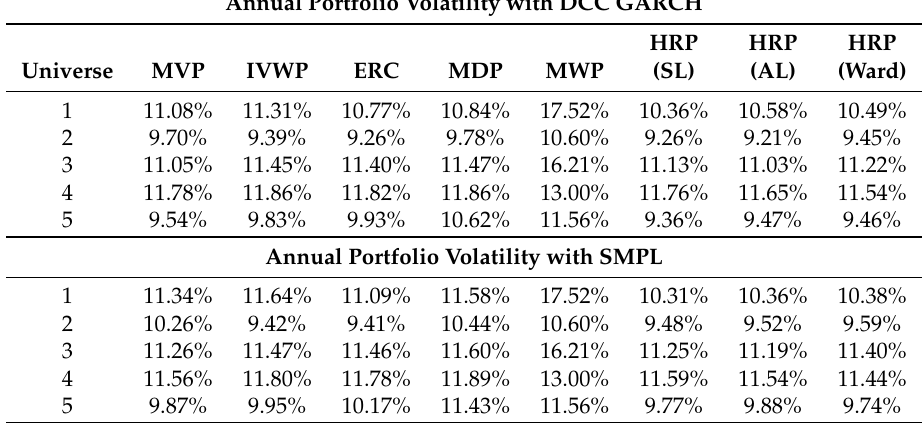
Table 5. The out-of-sample realized annual portfolio volatilities for different covariance forecast models when they were rebalanced